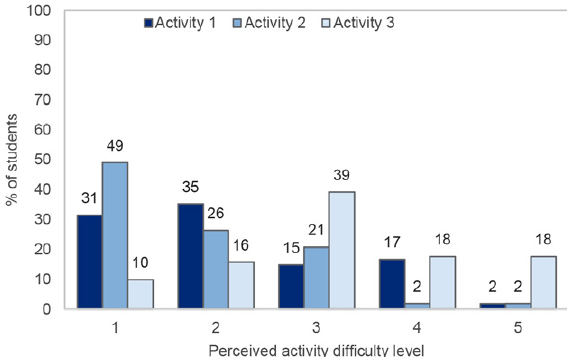
Figure 3: Mean scores with SD (whiskers) by activity for activity completion level (1–5), time spent on activity (min), and perceived activity difficulty (1–5)